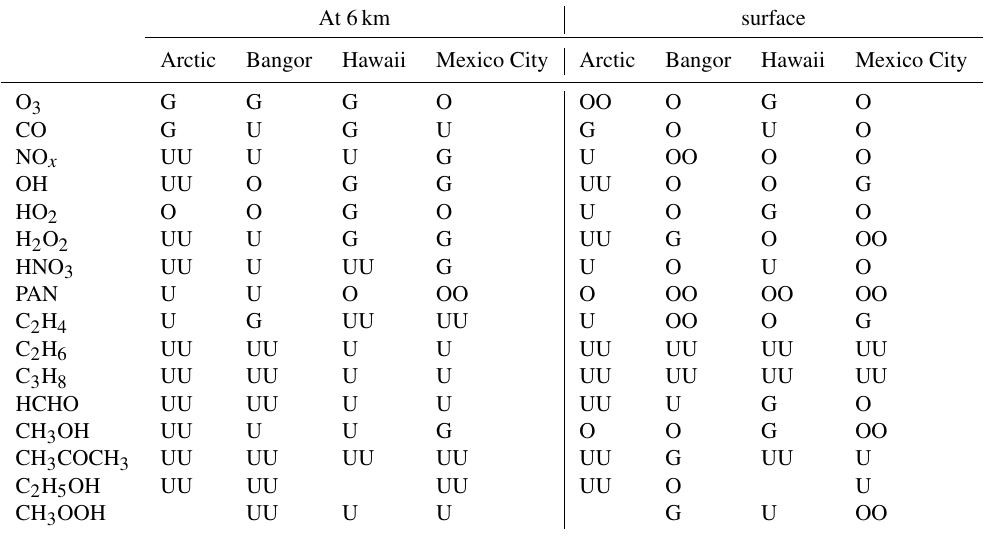
Table 6. Qualitative summary of the overestimation and underestimation by the CAMSRA for several observed chemicals at four geographic locations and at two altitudes (6km and the surface).